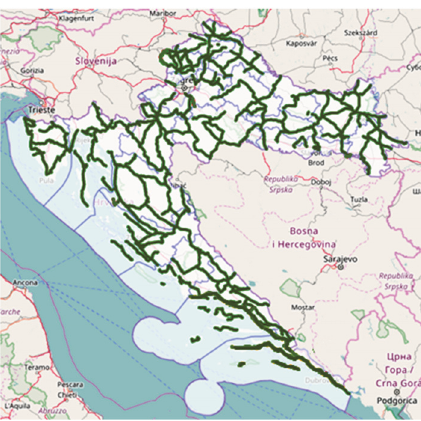
Figure 1: Selected state road in